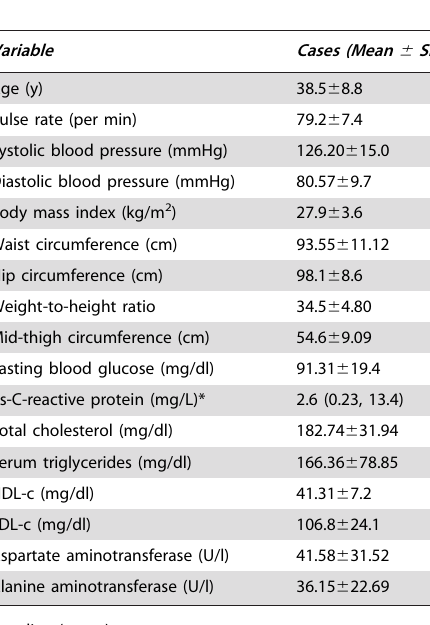
Table 3. Clinical and Biochemical